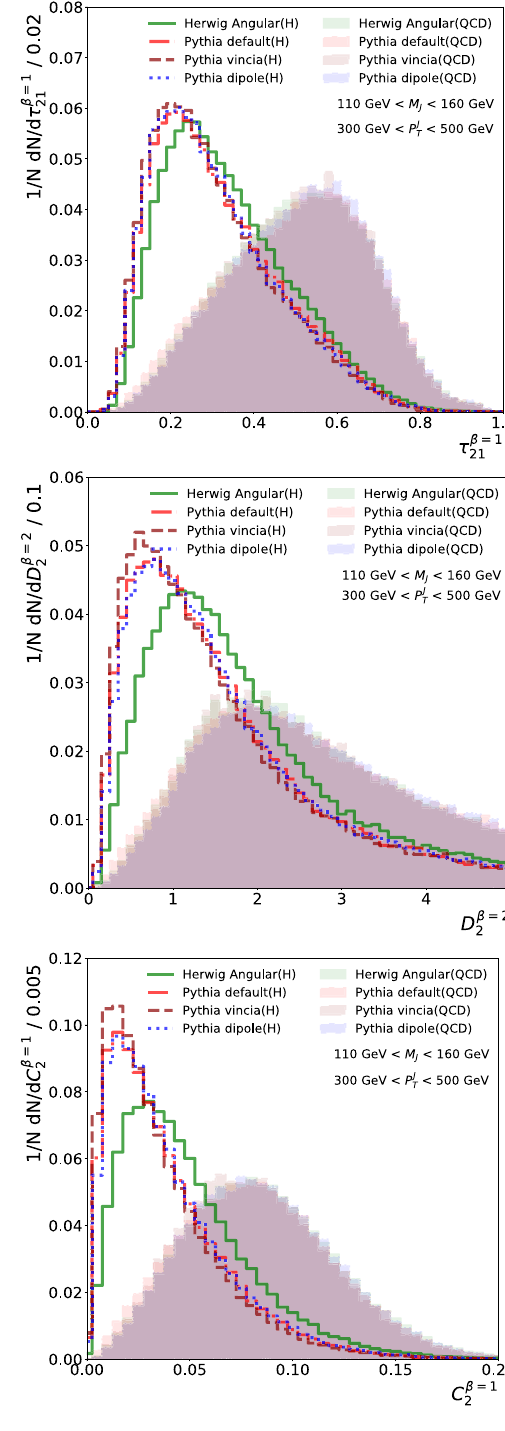
Fig. 1 The six high-level features used to distinguish boosted Higgs boson jets from QCD jets